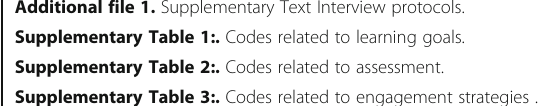
Supplementary Table 1:. Codes related to learning goals. Supplementary Table 2:. Codes related to assessment. Supplementary Table 3:. Codes related to engagement strategies .